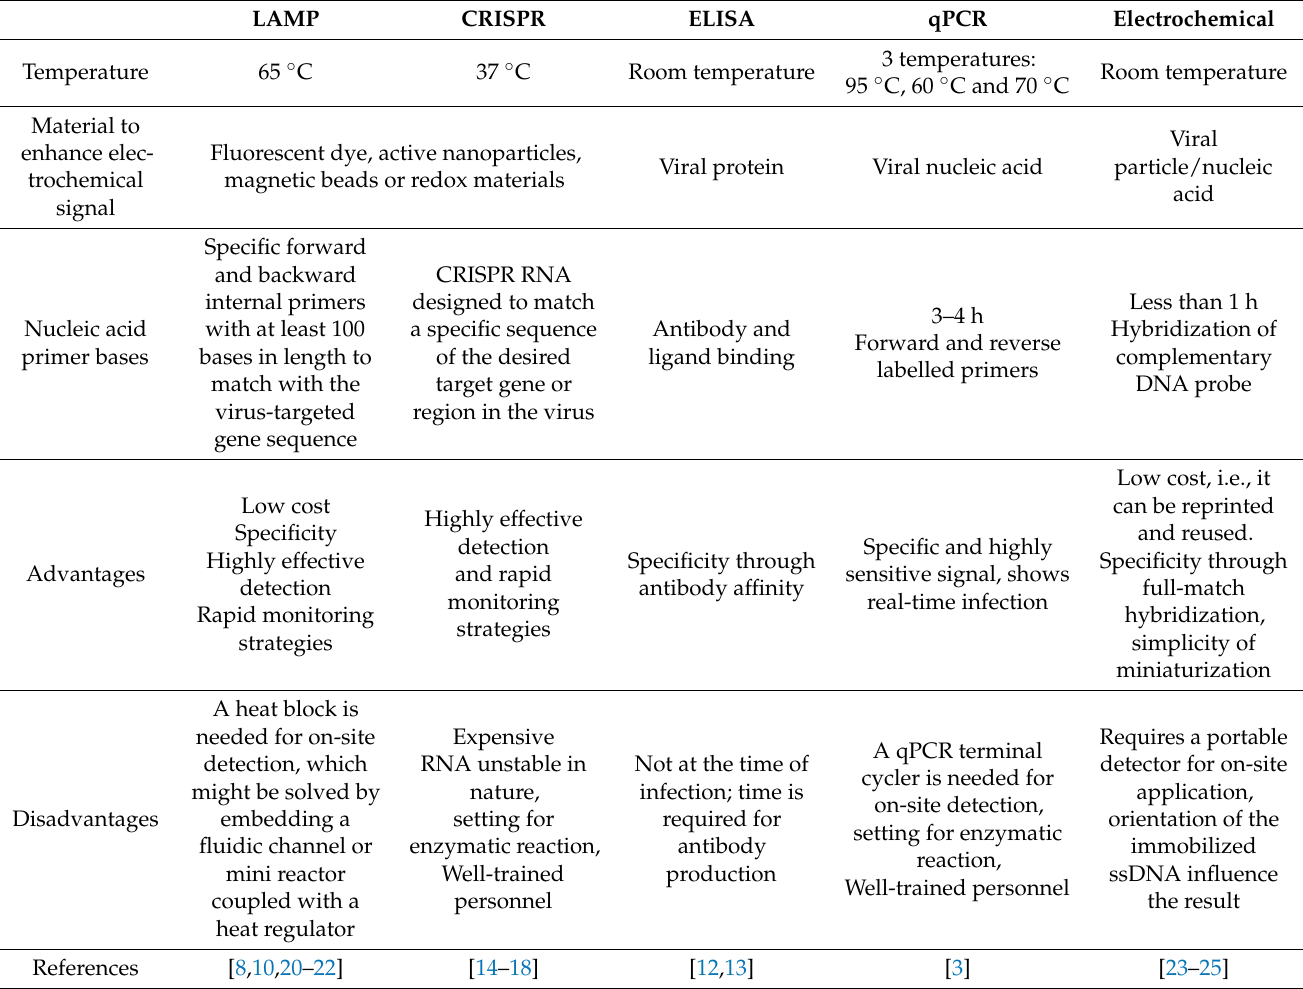
Table 1. Comparison of existing virus detection methods: LAMP, CRISPR, ELISA and electrochemical